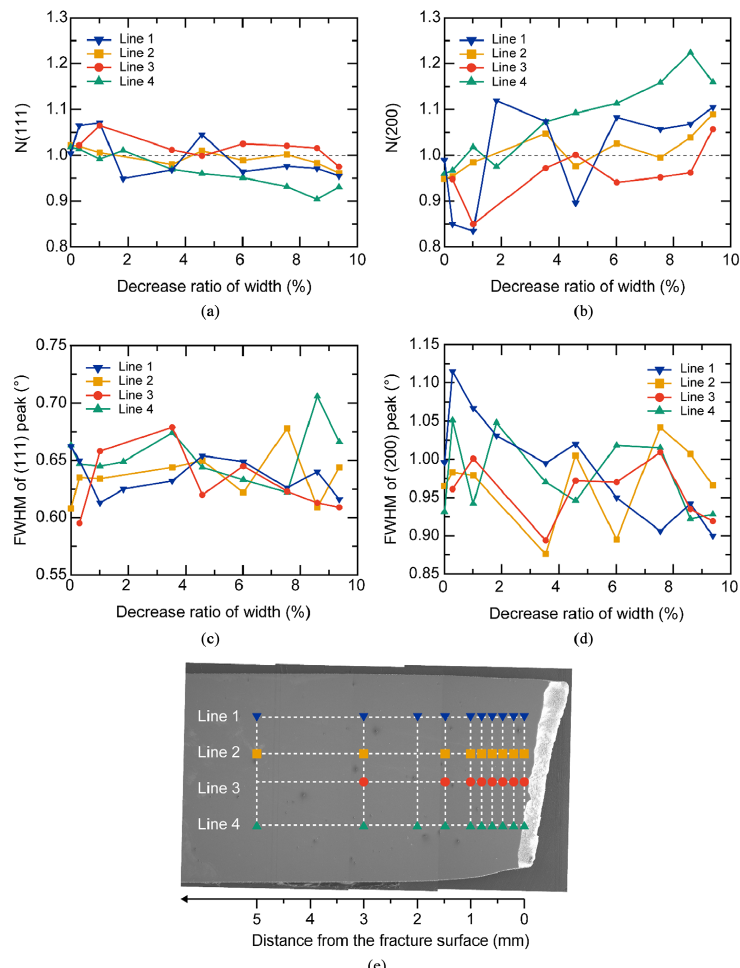
Figure 6. Normalized diffraction intensity of the (a) (111) peak and (b) (200) peak for the electrodeposited bulk nanocrystalline Fe-43Ni alloys after fracture. FWHM of the (c) (111) peak and (d) (200) peak for the electrodeposited bulk nanocrystalline Fe-43Ni alloys after fracture. (e) Scanning electron microscopy image showing the gauge section of the electrodeposited bulk nanocrystalline Fe-43Ni alloys.